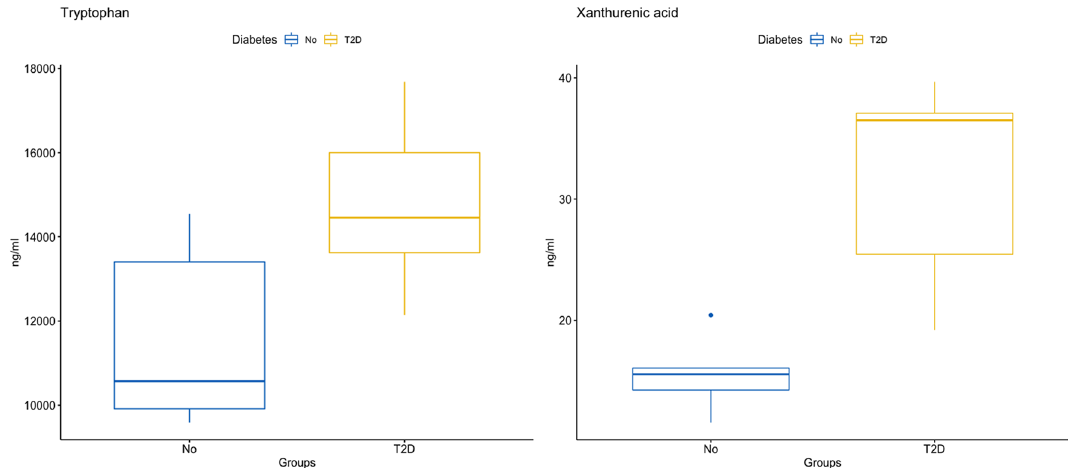
Figure 3. Baseline pre-operative concentrations of tryptophan and xanthurenic acid. T2D ND Pre Op Post Op p value q value Pre Op Post